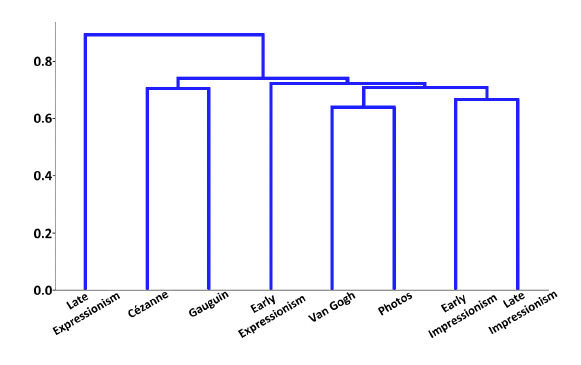
Figure 16: Hierarchical clustering constructed from the correla- tion matrix shown in Figure 15. It shows the clustering of styles based on the accumulated fixations.